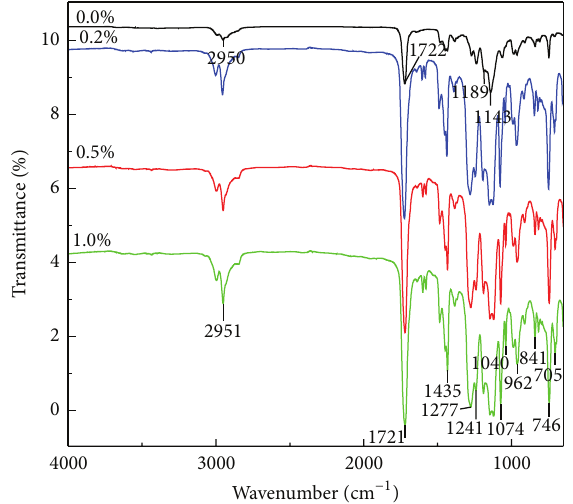
Figure 1: FTIR spectra of the cured base materials prepared with varying nanodiamond contents.